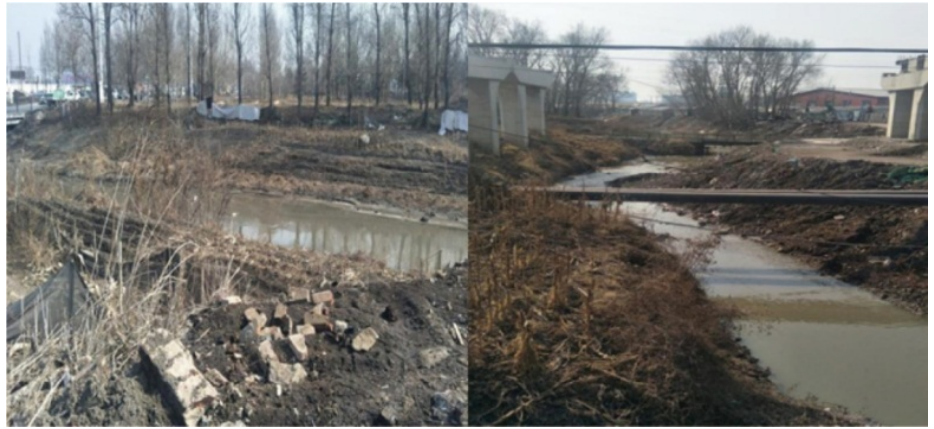
Figure 2. Typical VBZ along DX River before restoration. The photos were taken on 20 October 2017, before the DX river treatment project.